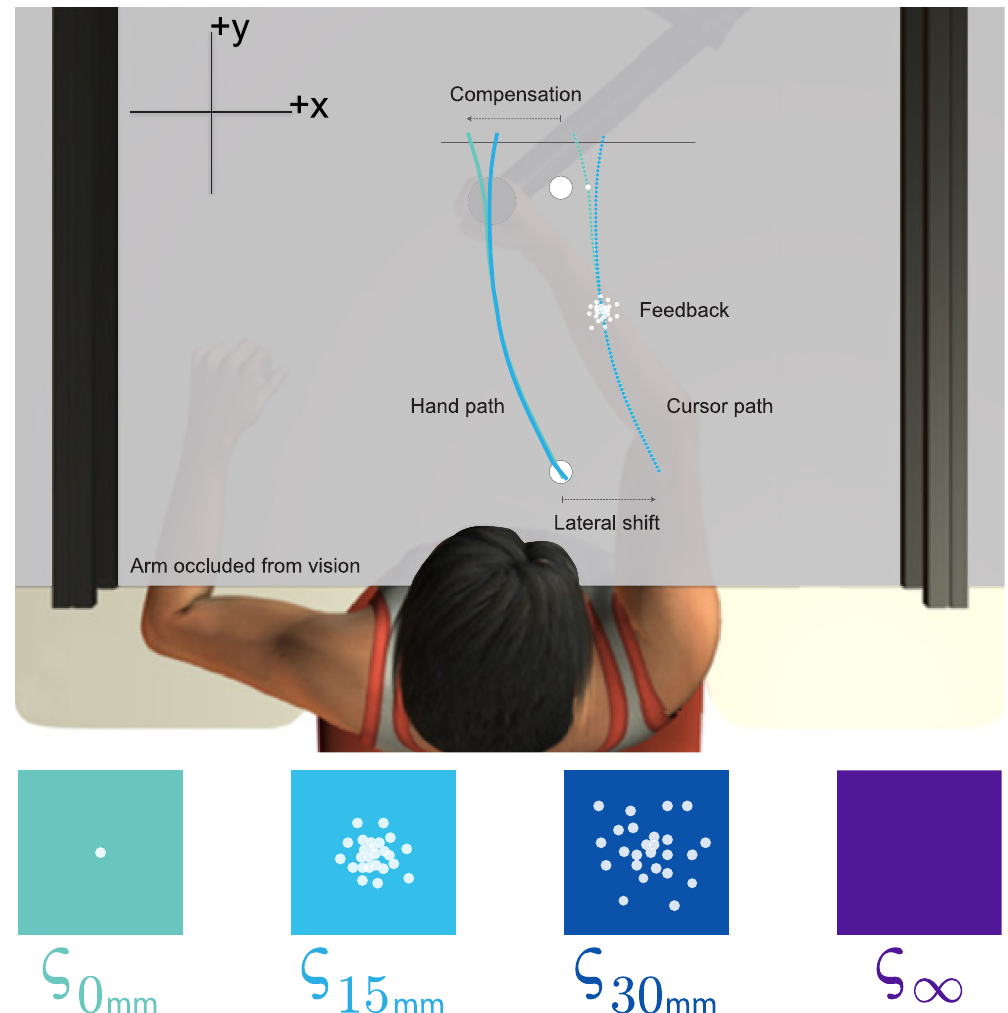
Fig 1. Experiments 1 and 2 : Participants held the handle of a robotic arm with their right hand. A semi- silveredmirror reflected the image (visual targets, visual feedback) from an LCD screen (not shown) onto a horizontalplane aligned with the shoulder. Participantsmade forward reaches from a home position,attempted to move through a visual target and stoppedonce their hand passed over a horizontal line that disappeared when crossed. Error (visual) feedbackand reinforcement (target expands,pleasant sound and monetary reward) feedbackwas laterally shifted relative to true handposition. The magnitudeof any particularlateral shift was drawn from a skewedprobabilitydistribution. Participantshad to compensatefor the lateral shifts to hit the target. Compensation representshow laterally displacedtheir hand was relativeto the displayedtarget. Experiment 1 : Laterallyshifted error feedbackwas flashed halfway through each reach as a single dot ( ς 0 mm ), a medium cloud of dots ( ς 15 mm ), a large cloud of dots ( ς 30 mm ), or withheld( ς 1 ). The cursor and hand (not visible)paths shown above illustrate compensation that depended on the amount of visual uncertainty ( ς 0 mm and ς 15 mm conditions shown). In the singledot ( ς 0 mm ) condition, participantsreceived additional feedback(error or error + reinforcement) at the target. Experiment 2 : Participants were providedwith error feedbackand or reinforcement feedbackonly at the